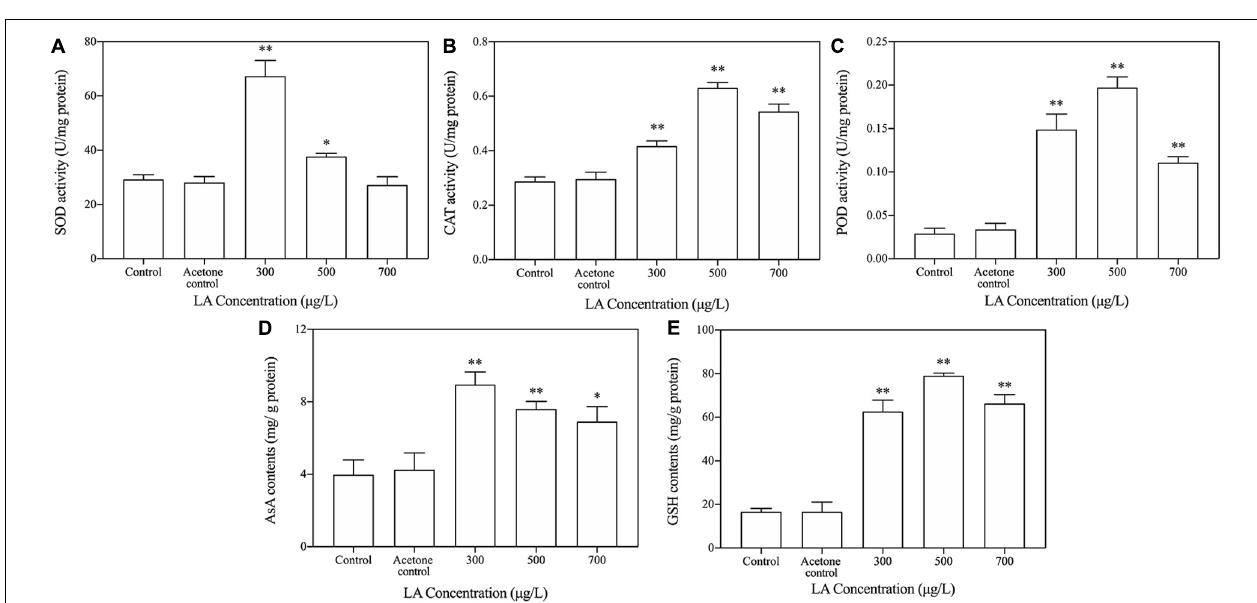
FIGURE 3 | LA-induced changes in cellular ROS levels and MDA contents in H. akashiwo . (A) O 2 - levels; (B) OH levels; (C) H 2 O 2 levels; (D) total ROS levels; (E) MDA contents. The data are presented as the mean ± SD ( n = 3). Asterisks indicate significant differences from acetone control ( ∗ indicate p < 0.05; ∗∗ indicate p < 0.01).